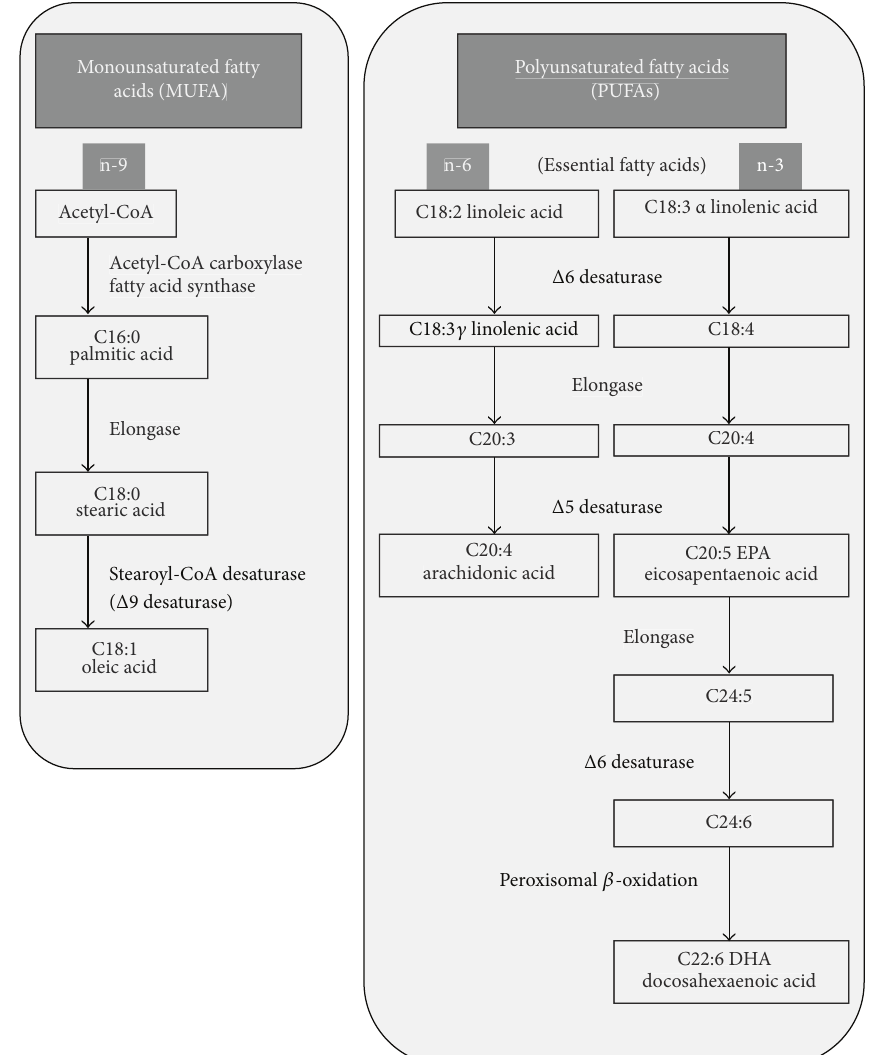
Figure 1: Synthesis of unsaturated fatty acids in mammals.